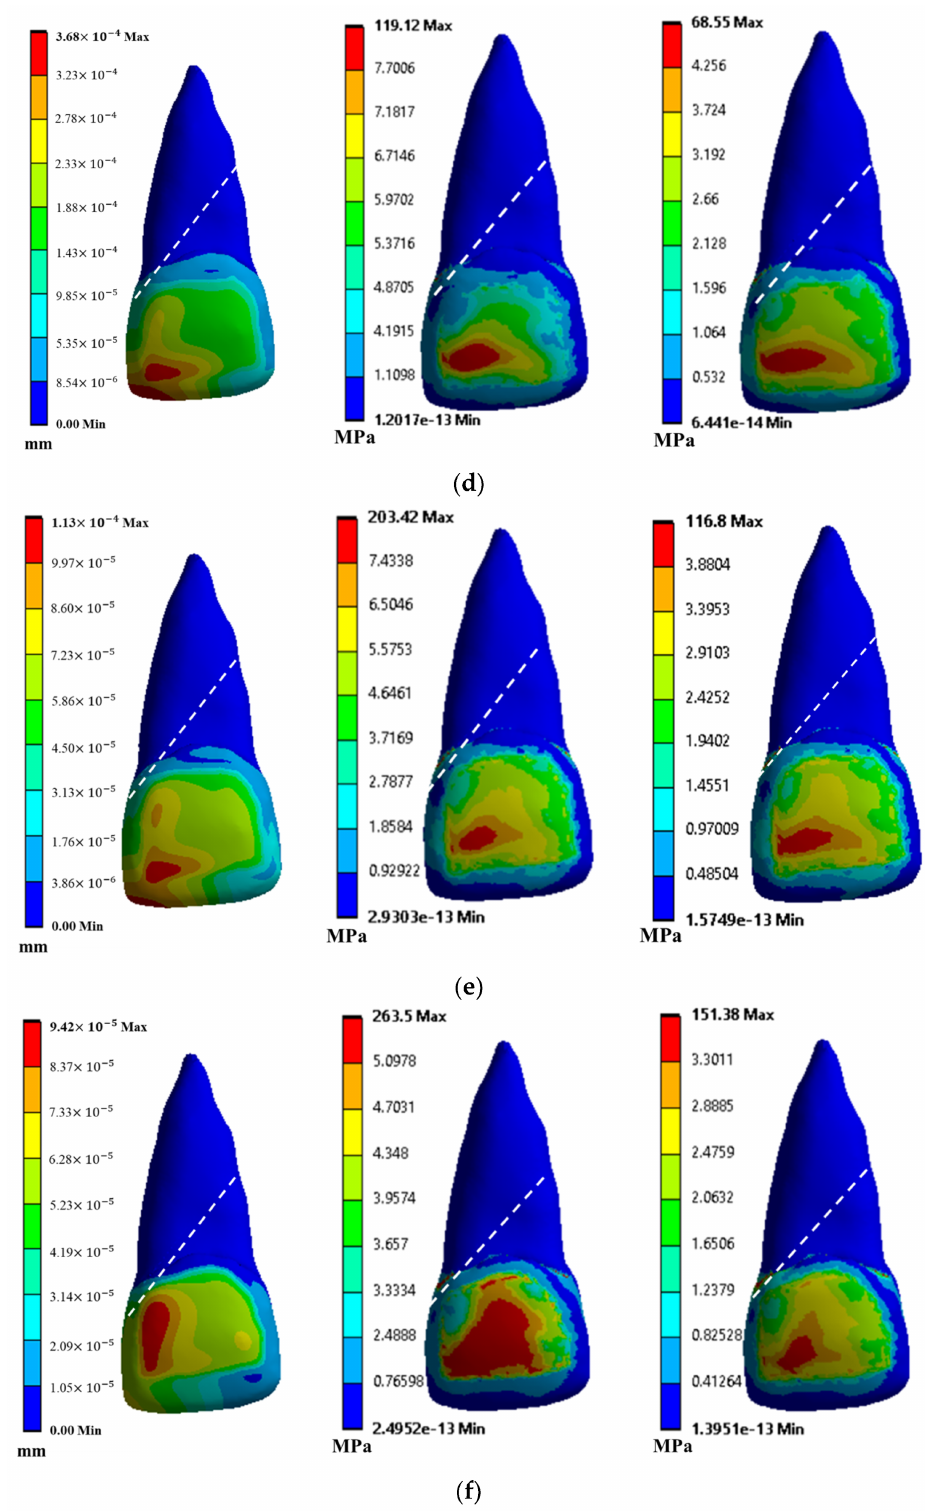
Figure 10. Displacement, stresses, and shear stresses across crown–root fracture: ( a ) masticatory loading in case of flowable composite, ( b ) masticatory loading in case of resin cement, ( c ) masticatory loading in case of resin adhesive, ( d ) traumatic loading in case of flowable composite, ( e ) traumatic loading in case of resin cement, and ( f ) traumatic loading in case of resin adhesive. The white dashed line in the figure represents the fracture